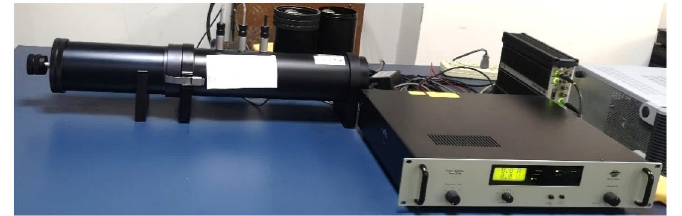
Fig 3. SAC testing system of the jute fiber felt.